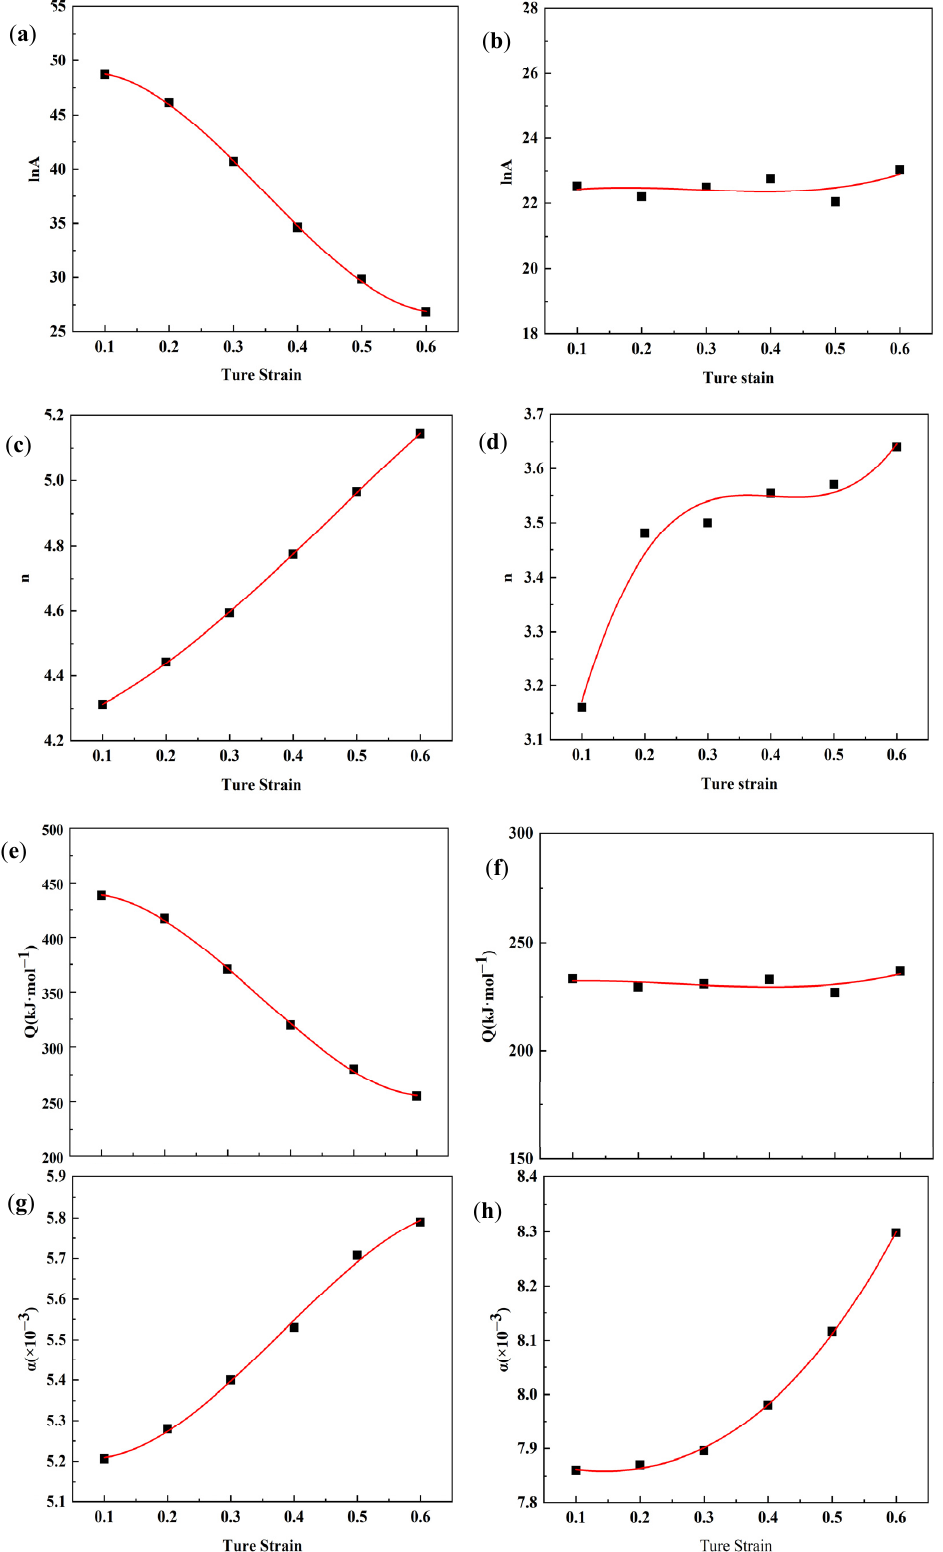
Figure 8. Relationship between model parameters and true strain: ( a ) ln A at α + β phase field, ( b ) ln A at β phase field, ( c ) n at α + β phase field, ( d ) n at β phase field, ( e ) Q at α + β phase field, ( f ) Q at β phase field, ( g ) α at α + β phase field, and ( h ) α at β phase